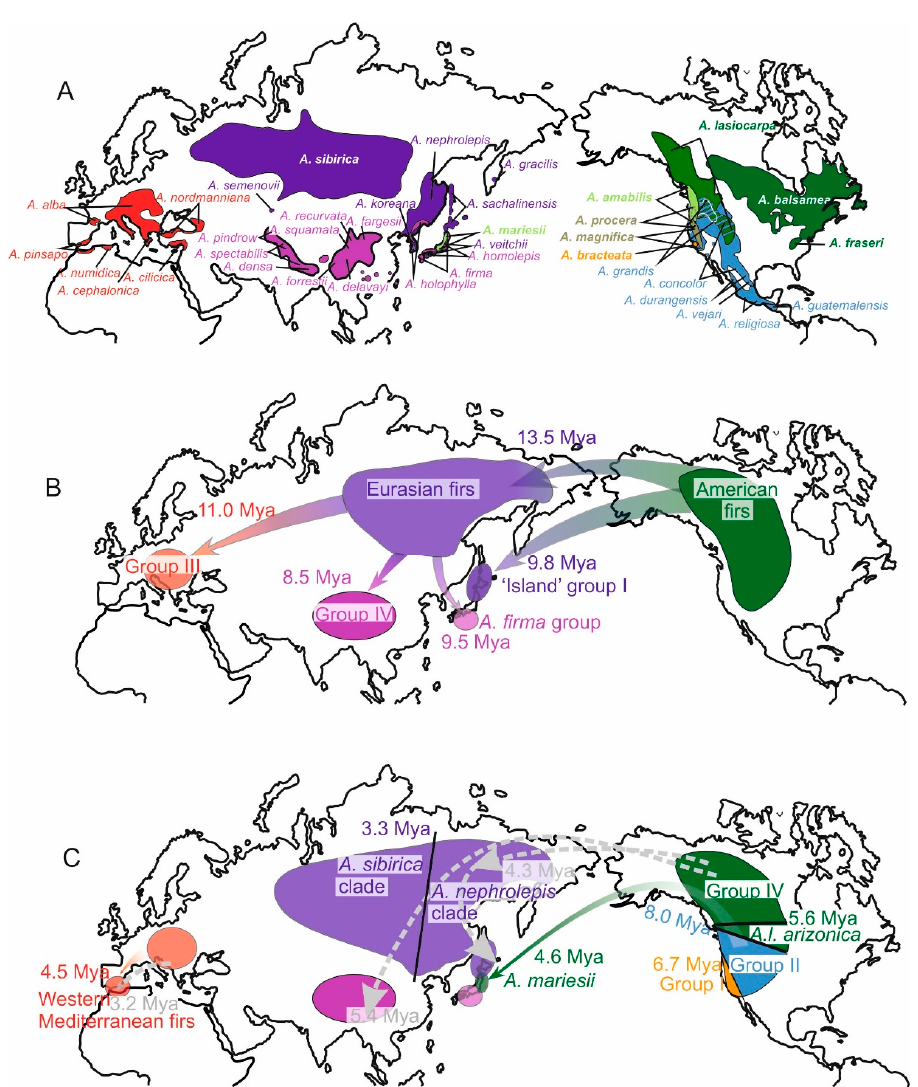
Figure 1. Distribution and colonization history of Abies species, suggested on the basis of mtDNA phylogeny (this study) and taking into account the results of biogeographic study based on nuclear DNA data [10]. The events of migration and isolation are presented with an age estimate. Recent and ancestral taxa are color-coded according to the nuclear DNA-based groups [10]. Additionally, the proposed migrations associated with introgressive hybridization and capture of mitochondrial genome of native species by migrants are indicated (dashed gray line). ( A ) Present species ranges; ( B ) Before 8 million years ago (Mya); ( C ) After 8 Mya years